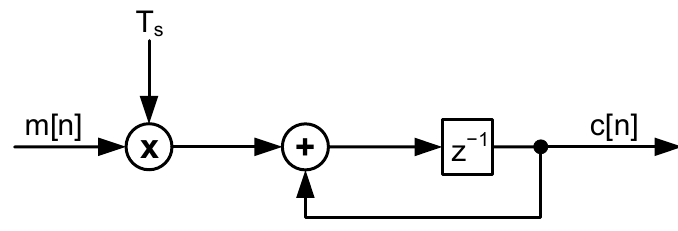
which translates to the diagram of Figure 18.